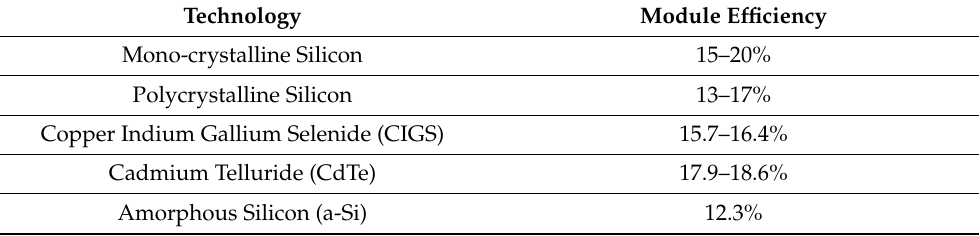
Table 2. Temperature coefficient of various PV cell technologies. Technology Crystalline Silicon − 0.109 to − 0.124